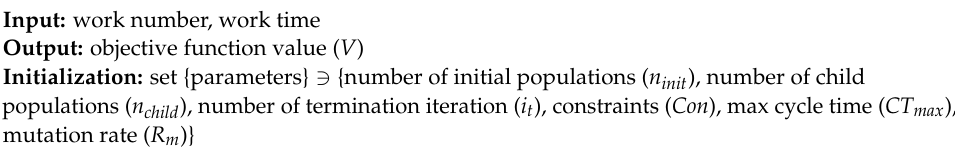
Algorithm 1: Heuristic-based optimization algorithm DT-based multi-objective genetic